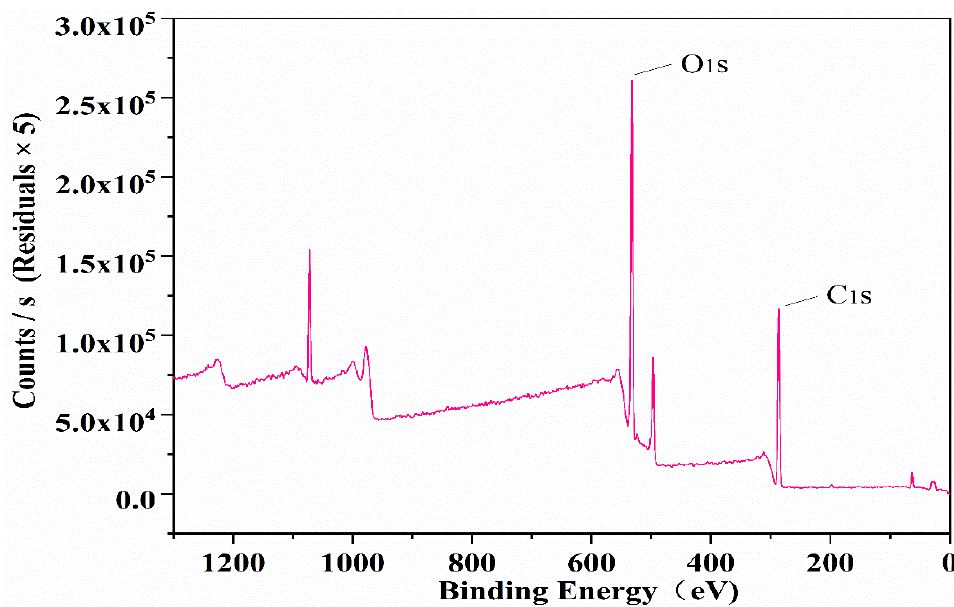
Figure 9. XPS full element scan of CMC.